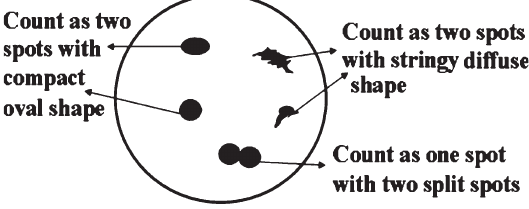
Fig. 6. Examples of stringy, splitting, and typical FISH